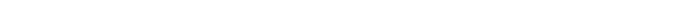
TABLE 1 | Putative target mechanisms: circadian and cognitive-emotional regulation. (a) → Target Symptom: Sleep; Target Mechanism: Rest-Activity (Circadian) Regulation Prolonged sleep onset latency and delayed sleep phase both peak in young adults (about 14% show these patterns) and both phenomena show inverse associations with mood and cognitive functioning in non-depressed samples. Further, the degree of circadian disturbance is significantly more marked in those with emerging mood disorders, with > 30% young adults with depression showing sleep phase delay according to objective actigraphy recordings. These rest-activity disturbances are reported in about 60% of those with emerging BD. Given the overlap between developmental and disease processes, we postulate that age-recognized shifts in rest-activity rhythms (usually a consequence of circadian dysregulation) act to precipitate or perpetuate illness in individuals at risk of BD or recurrent mood disorders and that targeting these abnormalities can improve outcomes. (b) → Target symptom: Rumination; Target Mechanism: Cognitive-Emotional Regulation Rumination is defined as a response to negative affect that involves “ repetitively and passively focusing on symptoms of distress and on the possible causes and consequences of the symptoms .” Rumination may comprise of two elements: an adaptive, reflective-distancing component (akin to “mindfulness”) and a less adaptive, more toxic element referred to as “brooding,” described as “getting depressed about being depressed.” It is a critical marker of cognitive-emotional dysregulation as the individuals’ focus on their distress (rather than on distraction to reduce dysphoria) and their passivity (rather than active problem-solving to resolve stressors) act together to intensify their negative affect. Ruminative response style is a robust risk factor for the development and maintenance of psychopathology, especially depression and recent evidence also implicates rumination in anxiety or comorbid anxiety-depressive states in younger (but not older) adults and in BD. Interestingly, those with high levels of rumination also show poorer sleep quality, and abnormal cortisol response to stress. Developmentally, the propensity to rumination peaks during middle and late adolescence (partly because of greater self-focus, etc.), and is more common in females.